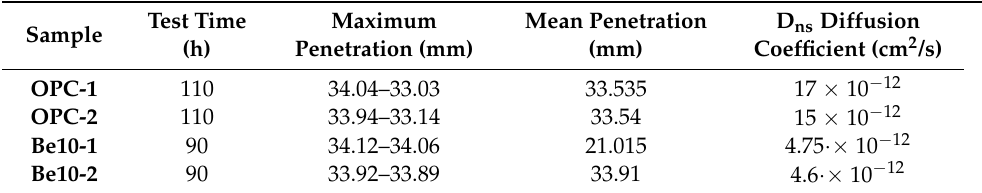
Table 3. Chloride non-steady-state non steady-state diffusion coefficient (D ns ) in reference (OPC) specimens and samples bearing 10% bentonite (Be10).